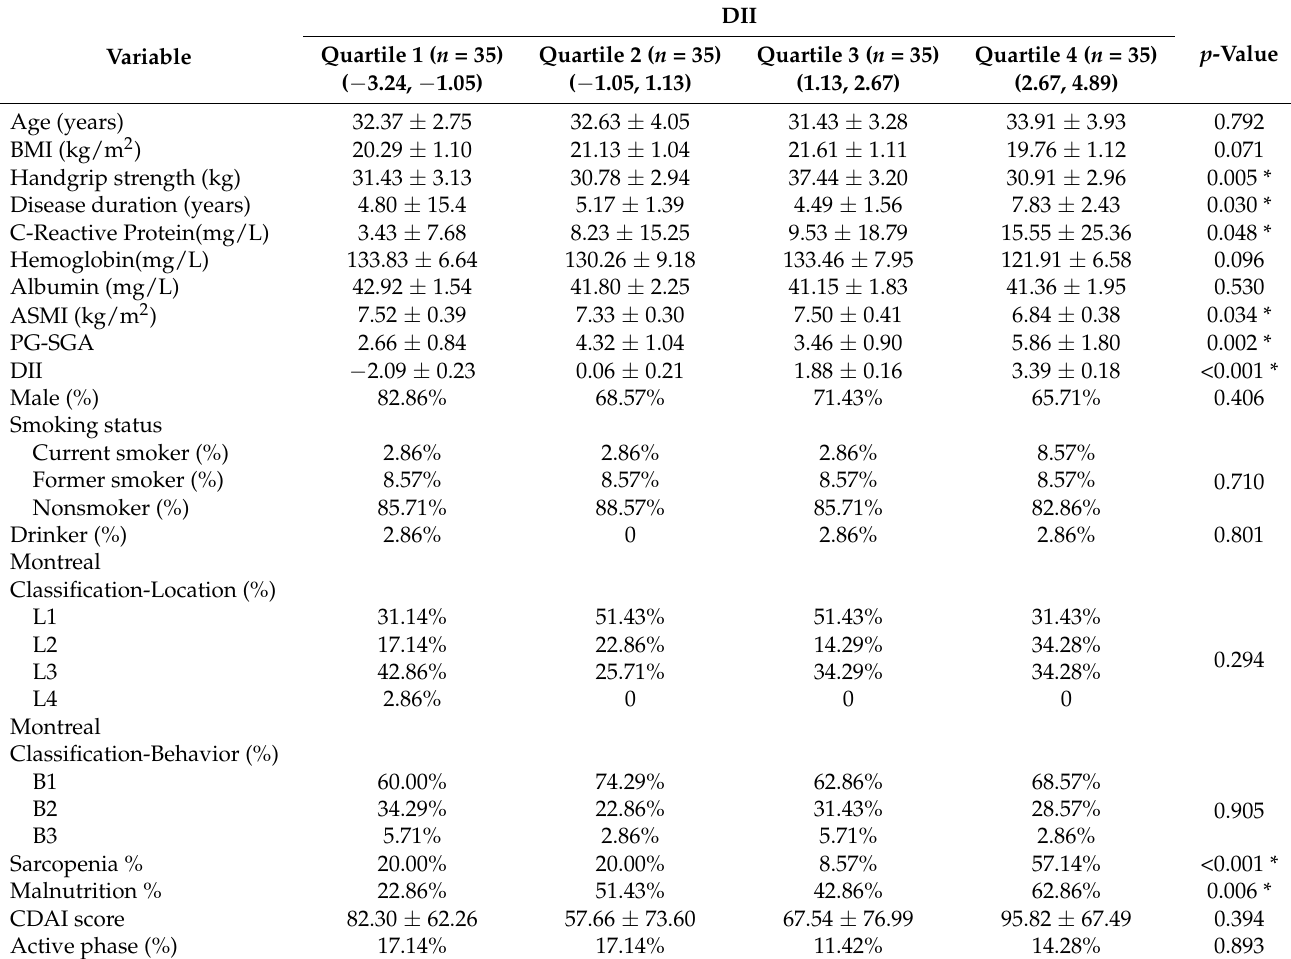
Table 1. Basic characteristics of patients stratified in the DII